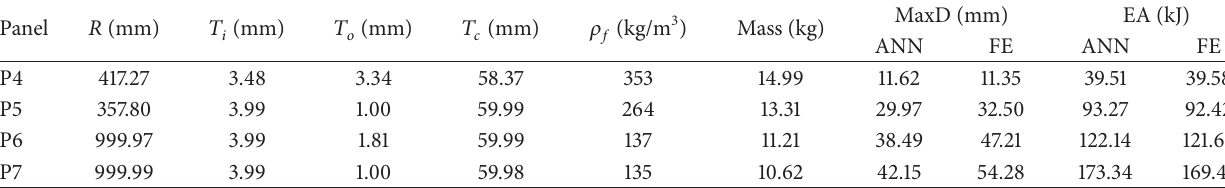
Table 6: Optimum panel designs for Case Study 2.